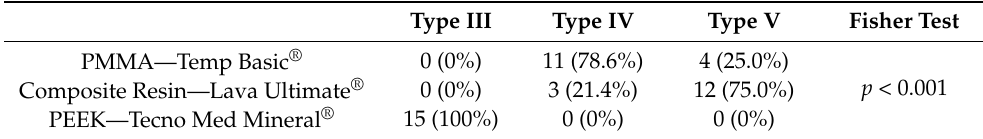
Table 5. Association between material and fracture types.